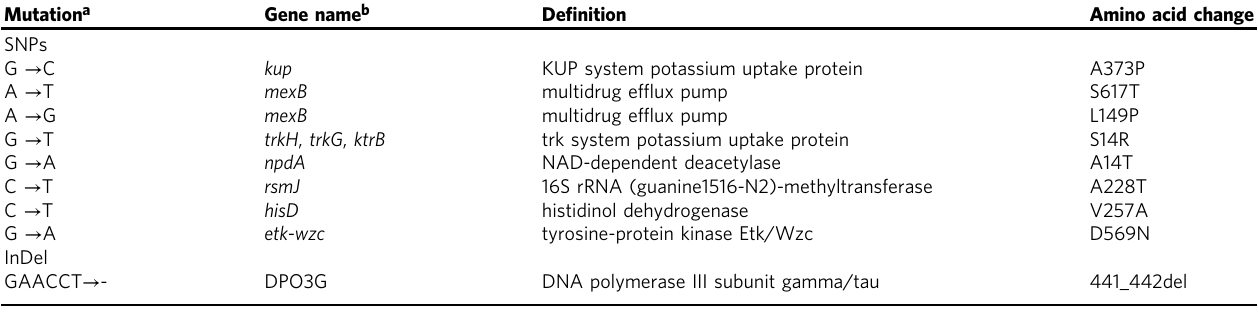
Table 3 Mutations present in RD53-resistant A.